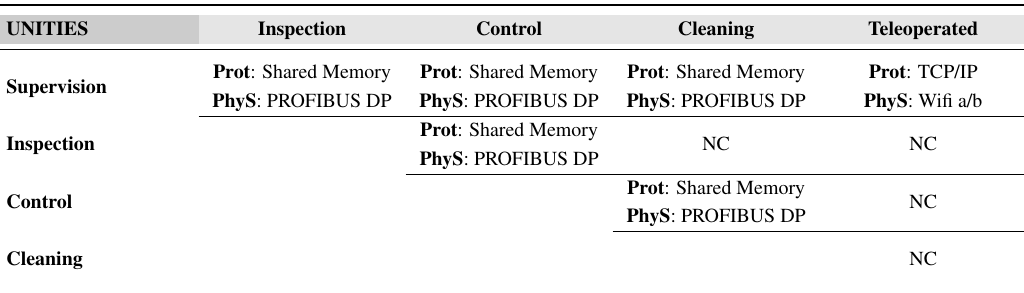
Table 1. Level 1: Communication between units.